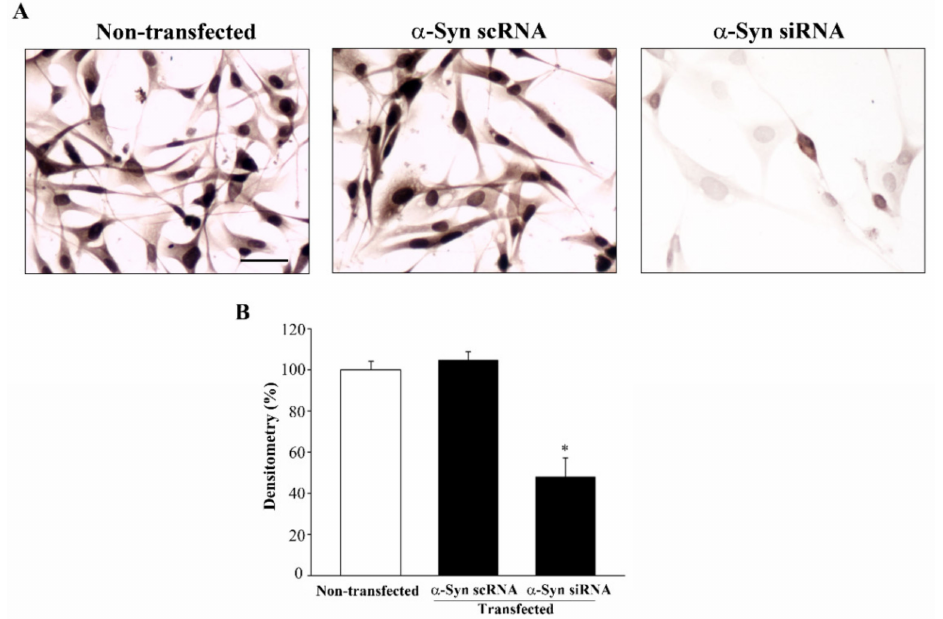
Figure 11. Silencing α -syn significantly reduced the nestin immunostaining. ( A ) Representative pictures are shown of nestin immuno-peroxidase from non-transfected, α -syn scRNA-transfected, and α -syn siRNA-transfected cells. ( B ) Graph reports the densitometry measured in the whole cells. Data are given as the mean percentage ± SEM of n = 30 counts obtained in N = 3 independent experiments. * p < 0.05 compared with non-transfected cells. Scale bar = 35 µ